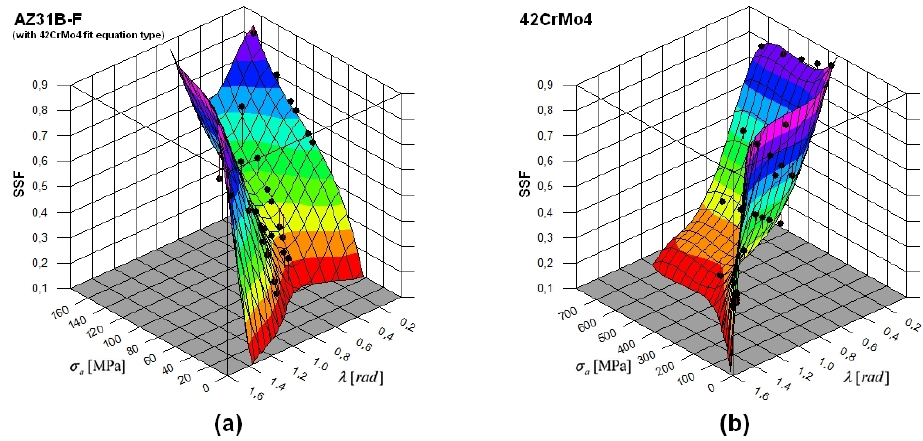
Figure 7. ssf graph of both materials using the 42CrMo4 fit equation (Equation (3). ( a ) Case of AZ31B-F magnesium alloy, ( b ) Case of 42CrMo4 high strength material.